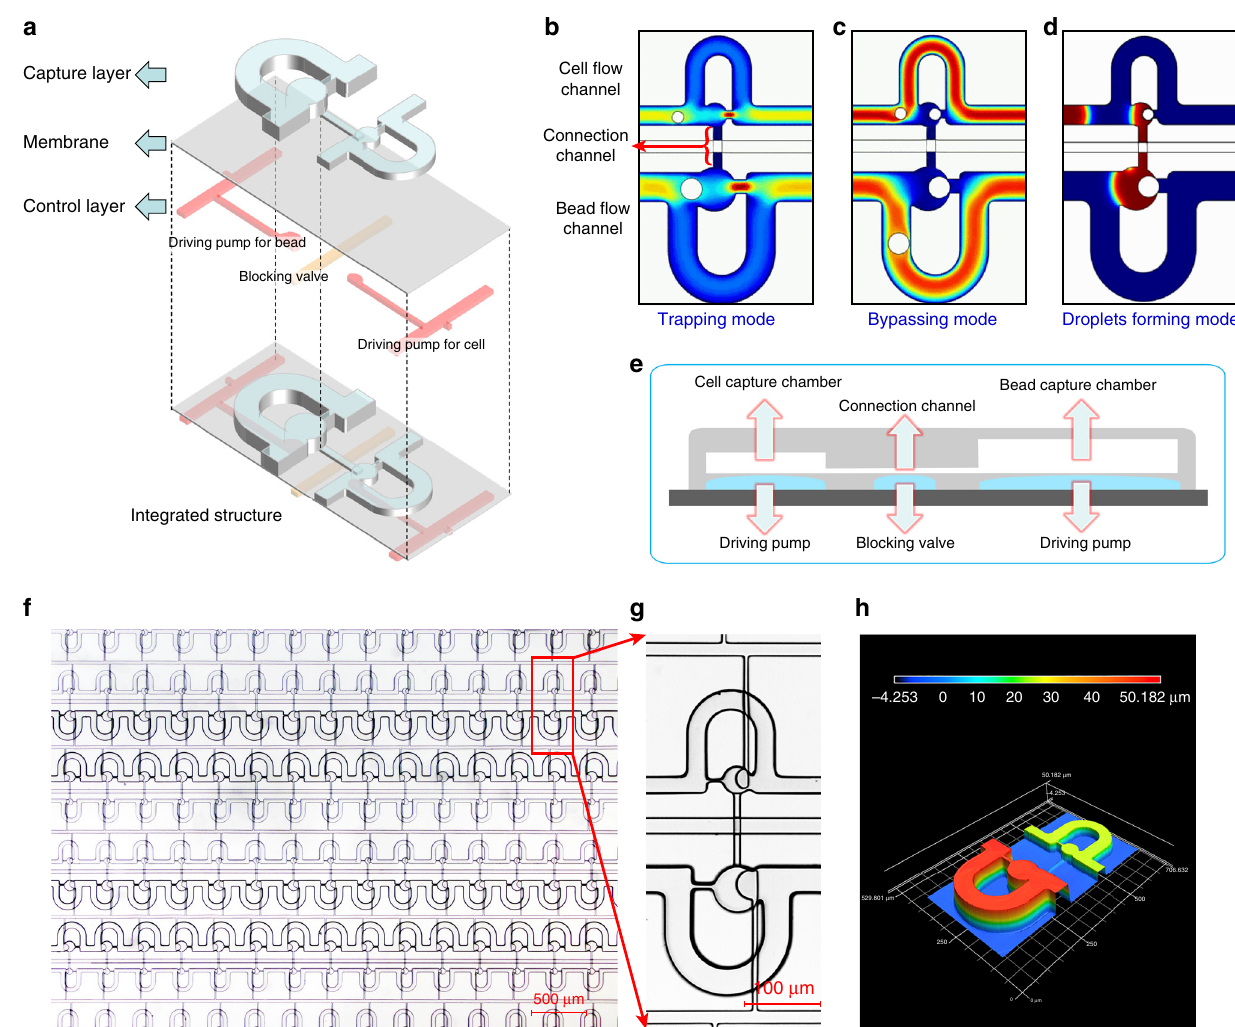
Fig. 2 Design criterion and structure characterization of Paired-seq chip. a The 3D cartoon diagram of the capture layer and the control layer of the chip. b, d The simulation results of trapping mode ( b ), bypassing mode ( c ) and droplets forming mode ( d ). e The cartoon diagram of cross section for one unit in Paired-seq chip. f , g Structure characterization of Paired-seq chip. Top view image of a Paired-seq chip with 800 units ( f ) and one paired unit ( g ). h The 3D surface pro fi ling of SU8 silicon model of the fl ow layer for one paired unit by 3D laser scanning confocal